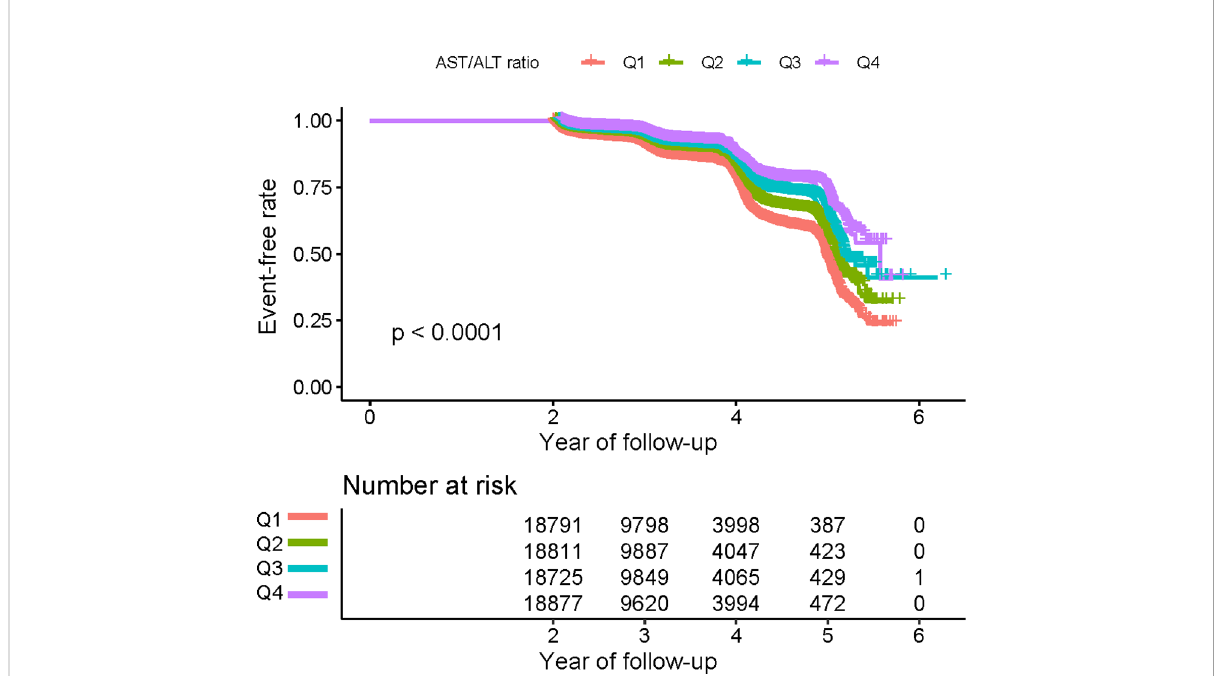
FIGURE 2 Kaplan – Meier event-free survival curve. Kaplan – Meier event-free survival curve. Kaplan – Meier analysis of incident prediabetes based on AST/ ALT ratio quartiles (log-rank, P <